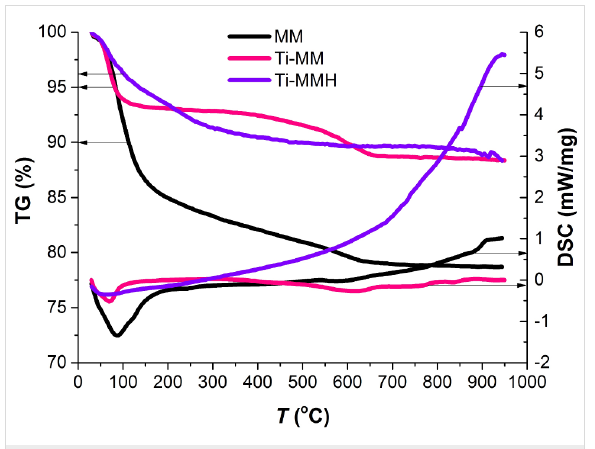
Figure 4: Thermogravimetric analysis (TGA)/differential scanning calo- rimetry (DSC) curves of the raw MM, Ti-MM, and Ti-MMH.